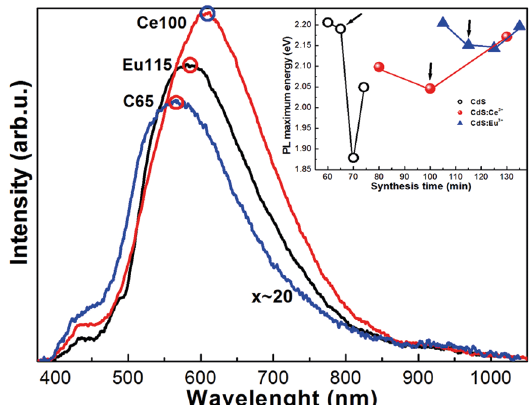
Figure 11. Comparison of the best spectra of luminescence, as is observed the luminescence of the doped samples are shifted to